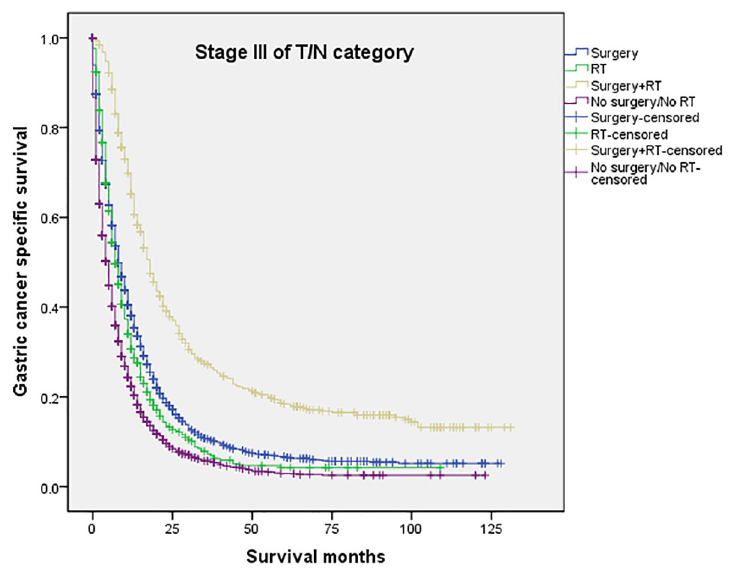
Fig 4. Survival curves in patients with advanced gastric cancer according to four subgroups in stage III of T/N category (P < 0.001). RT: radiation.